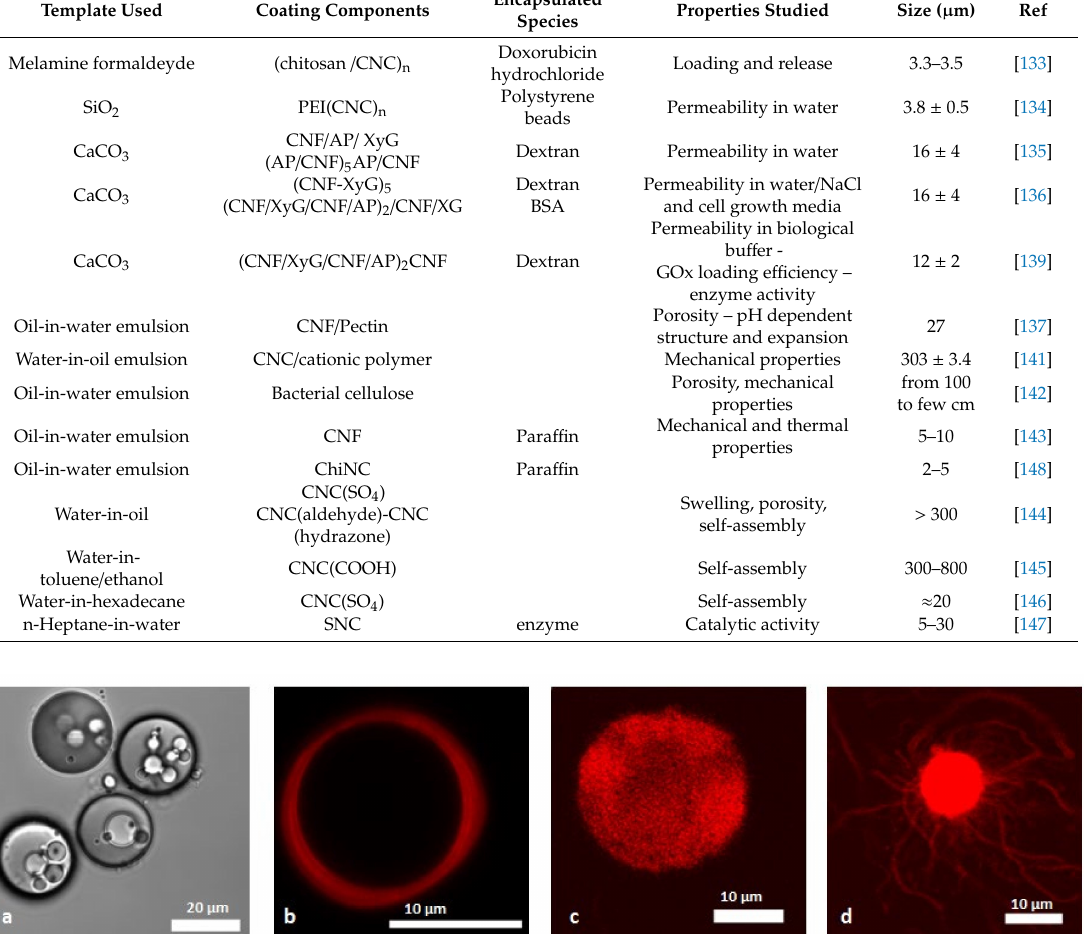
Table 2. Microcapsules stabilized by polysaccharide nanomaterials stabilized by electrostatic and H-bonds interactions.